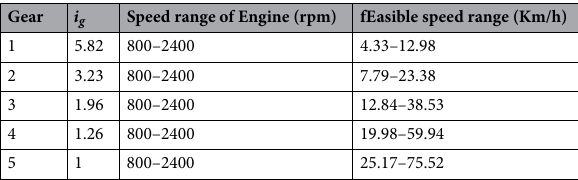
Table 3. The feasible speed range of each gear.